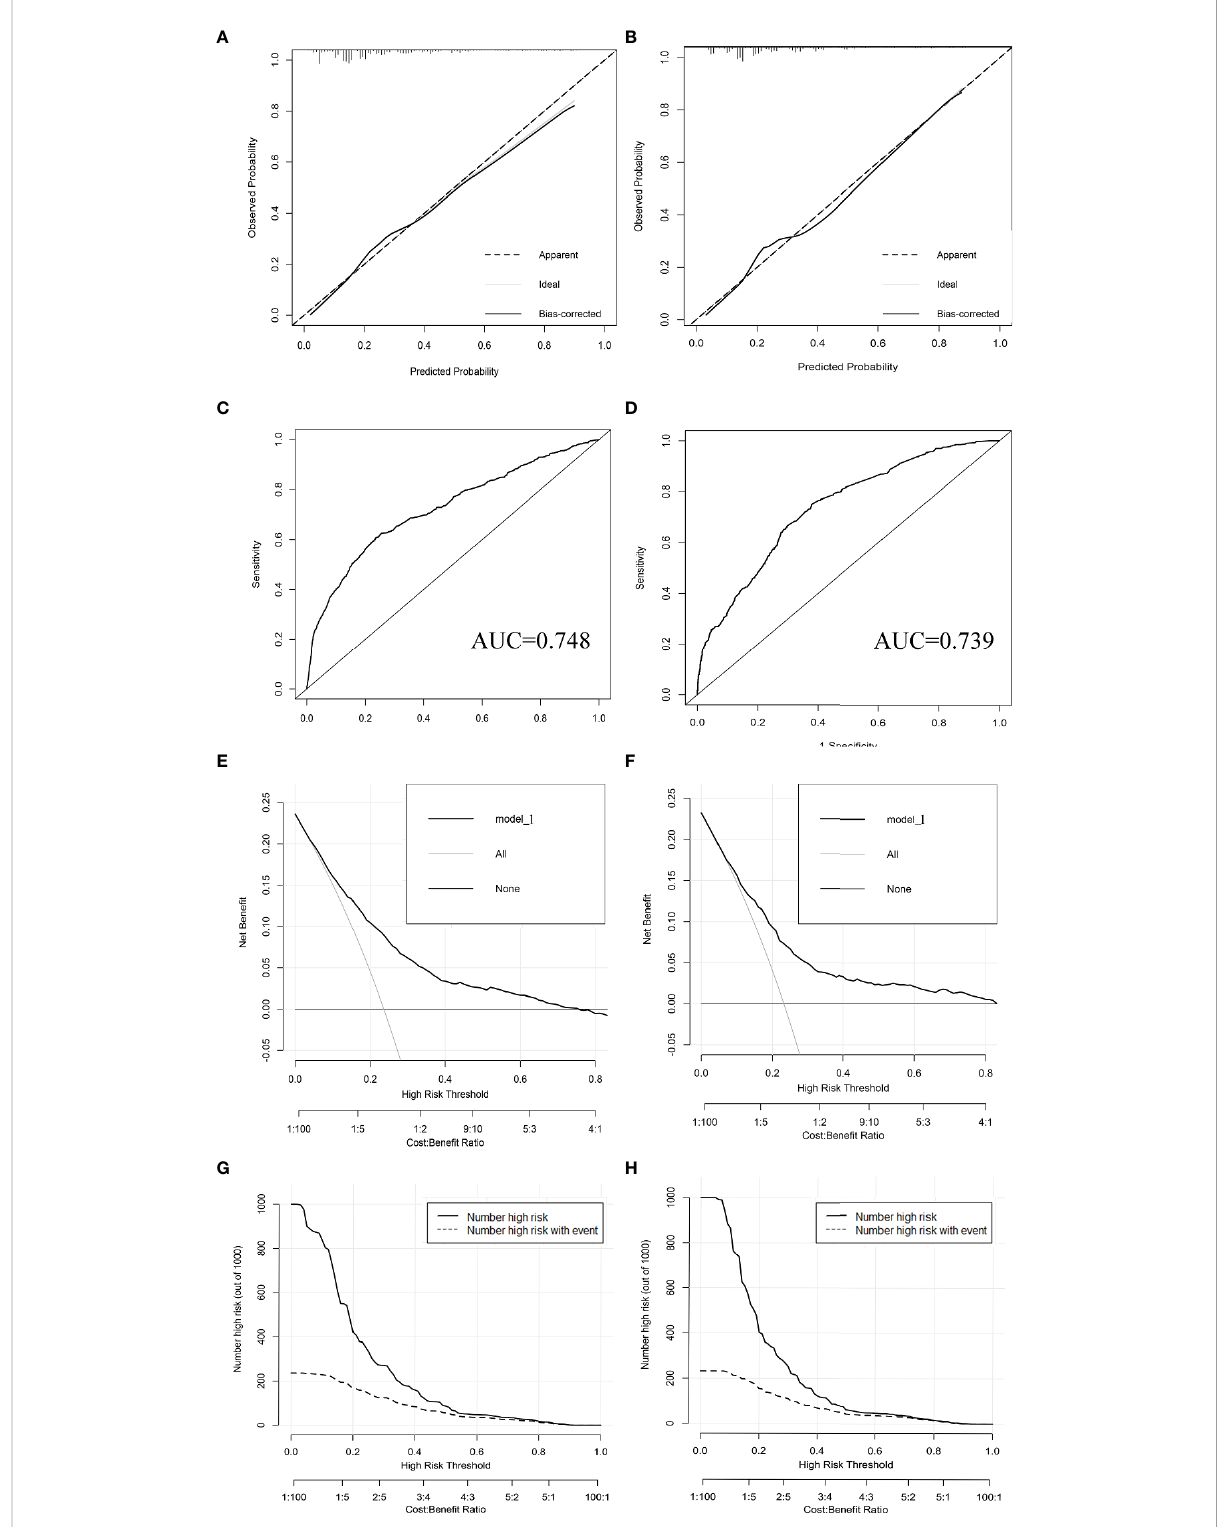
FIGURE 4 Calibration curves (A, B) , ROC curves (C, D) , decision curve analysis (E, F) , and clinical impact curves (G, H) were used to evaluate the prediction performance of the T 1-2 -stage CC nomogram. (A, C, E, G) for internal validation; (B, D, F, H) for external veri fi